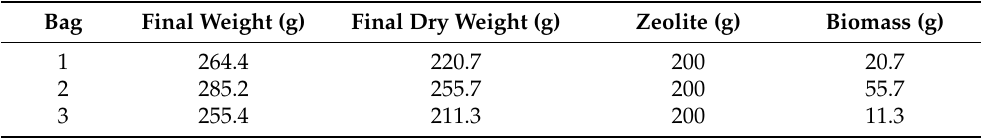
Table 3. Contaminant control experiment